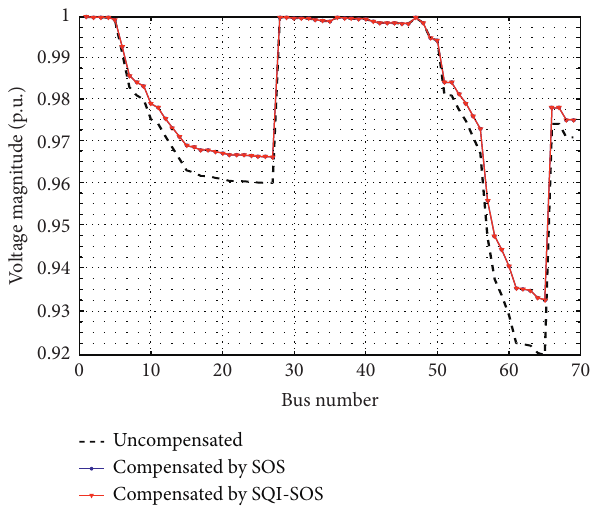
Figure 14: Voltage profile of the 69-bus system before and after compensation with the mixed load